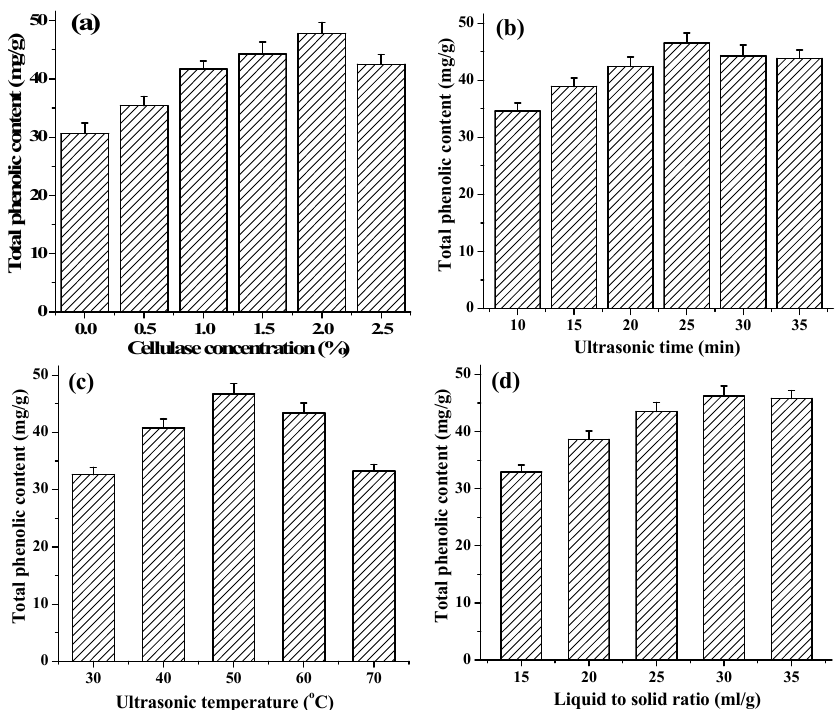
Figure 1. Effects of different extraction parameters on the yield of phenolic extracts: ( a ) cellulase concentration (%); ( b ) extraction time (min); ( c ) extraction temperature (°C); and ( d ) liquid to solid ratio (mL/g).